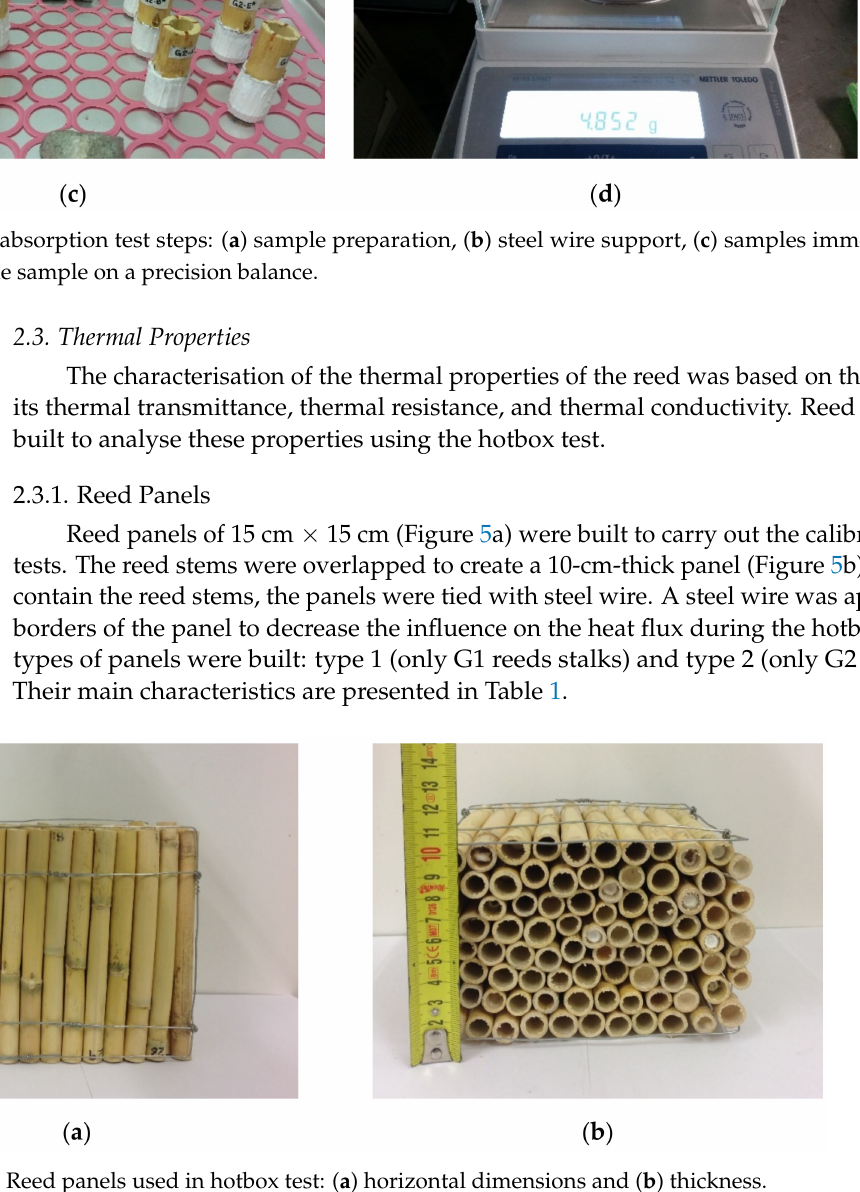
Figure 5. Reed panels used in hotbox test: ( a ) horizontal dimensions and ( b ) thickness. Table 1. Characteristics of the panels used in the hotbox